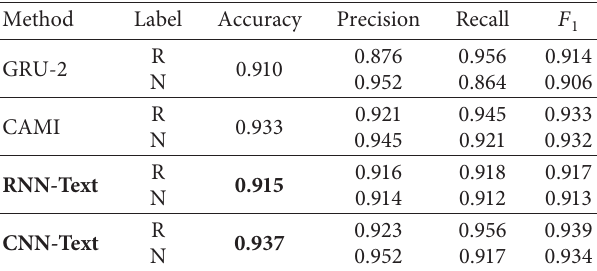
Table 5: Performance of proposed text content model (R: rumor; N: